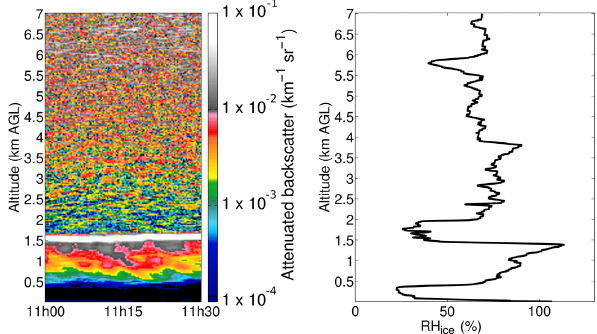
Fig. 8. Comparison between measured attenuated backscatter by ceilometer (left) and RH ice by radiosonde (right) at Summit on 5 August 2011.